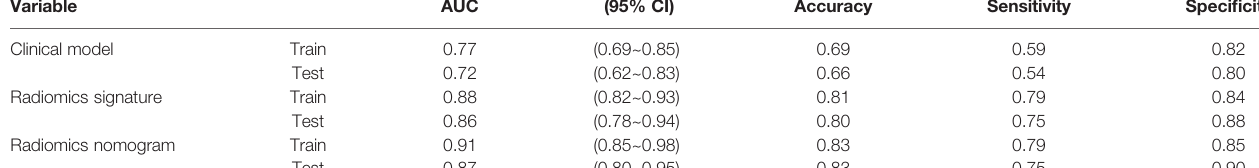
TABLE 5 | Predictive ability of the radiomics nomogram, radiomics signature, and clinical model for the classi fi cation of low and high Ki-67 lung cancer. Variable AUC Clinical model